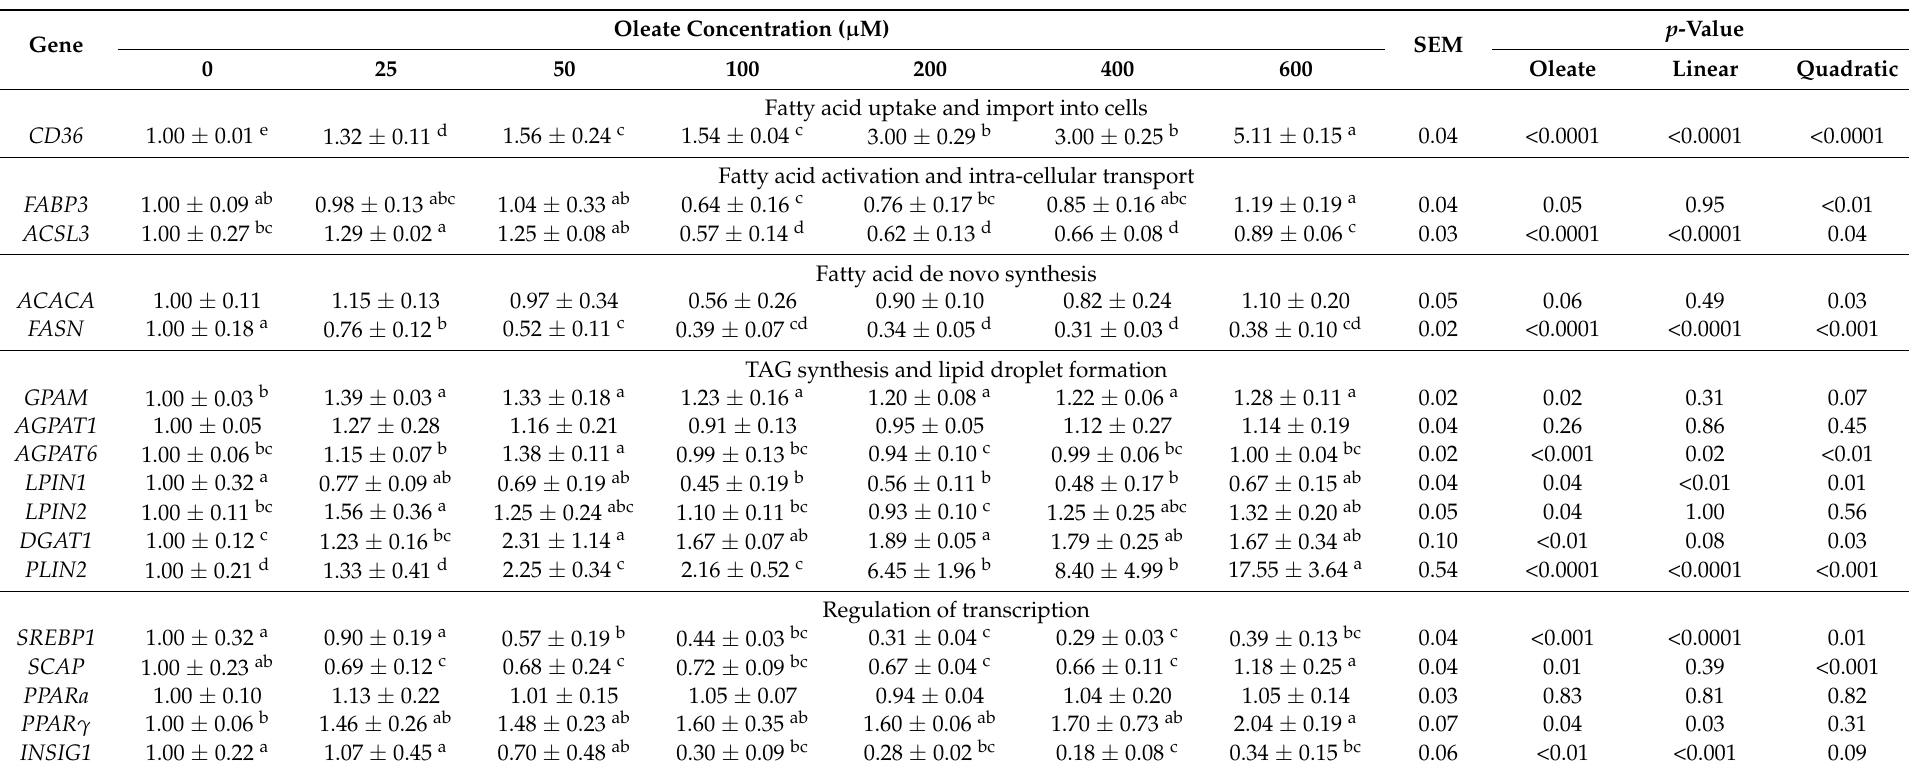
Table 2. Effect of oleate on mRNA expression of genes involved in lipid synthesis in pMECs 1